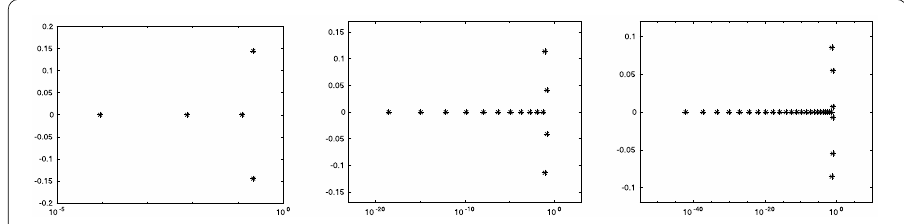
Figure 13 Eigenvalues of U n in the case of the Laguerre weight function for n = 5,15,30 (from left to